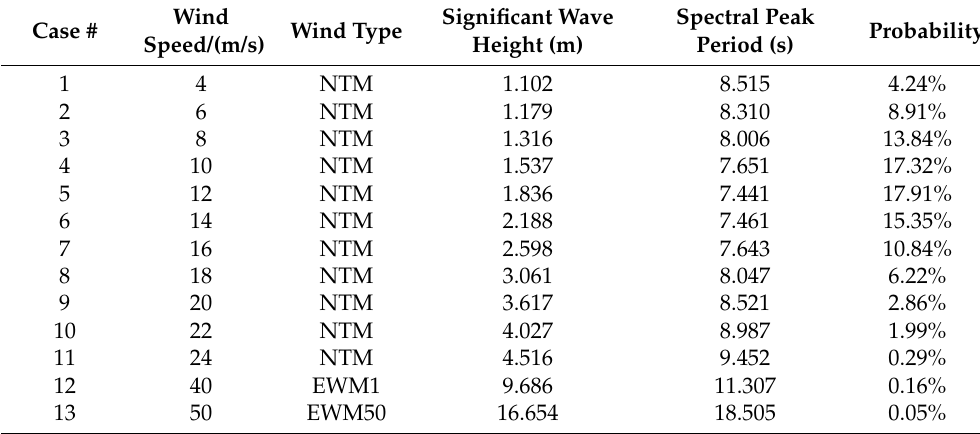
Table 5. Design load cases.